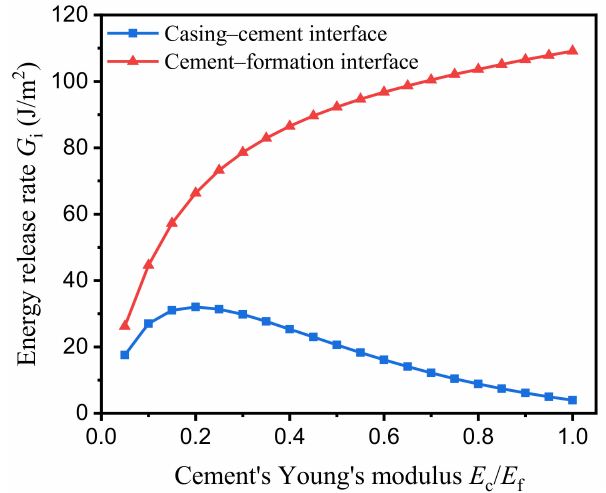
Figure 4. Variation of the energy release rates for interfacial debonding with the Young’s modulus of